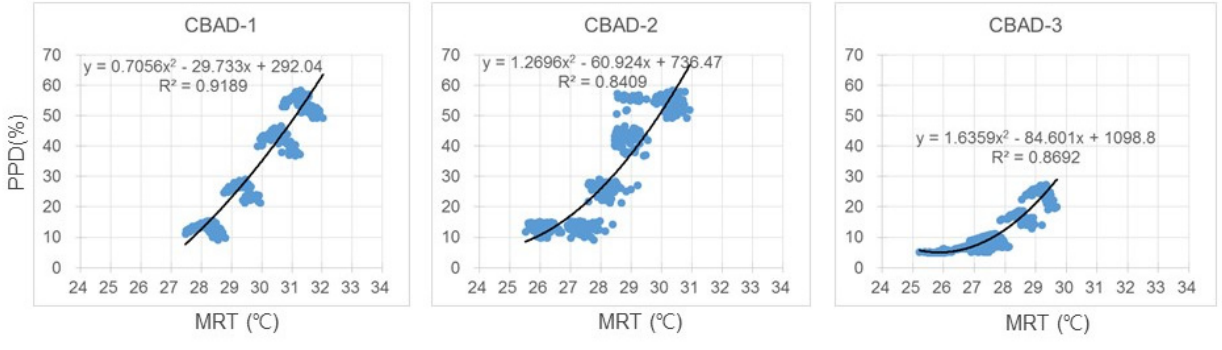
Figure 26. Correlation between MRT and PPD for CBAD.